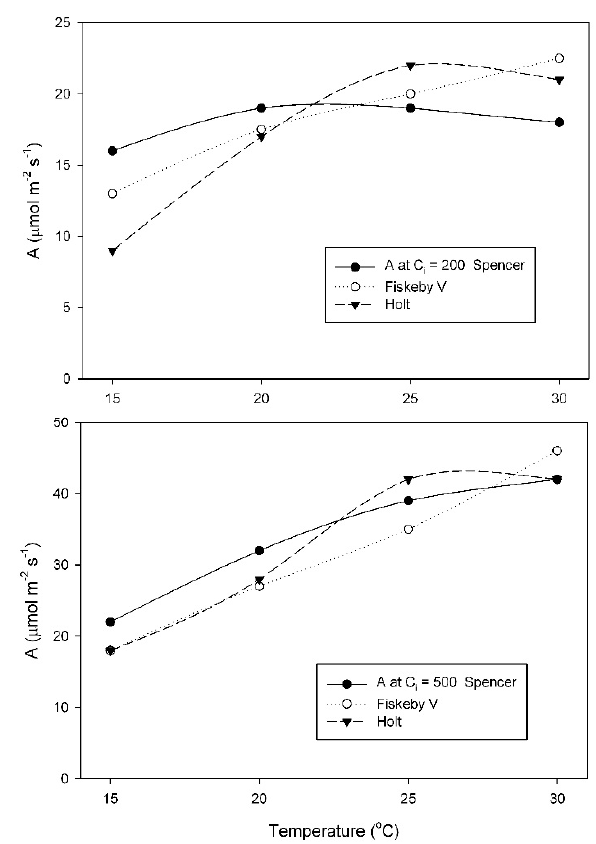
Figure 4. Values of A measured at either C i = 200 µ mol mol − 1 , or at C i = 500 µ mol mol − 1 CO 2 for three soybean cultivars grown at 25 ◦ C. Each point represents a mean for 3 or 4 leaves. Statistical comparisons are given in Tables A4 and A6. Table 1. Mesophyll conductance to CO 2 movement from the intercellular airspace to the site of fixation (g m ) in three soybean cultivars grown at three temperatures, and measured over the range of 15 to 30 ◦ C. Values are means for 3 or 4 leaves. Values followed by di ff erent letters are di ff erent at p = 0.05, using analysis of variance on log transformed data in order make variances